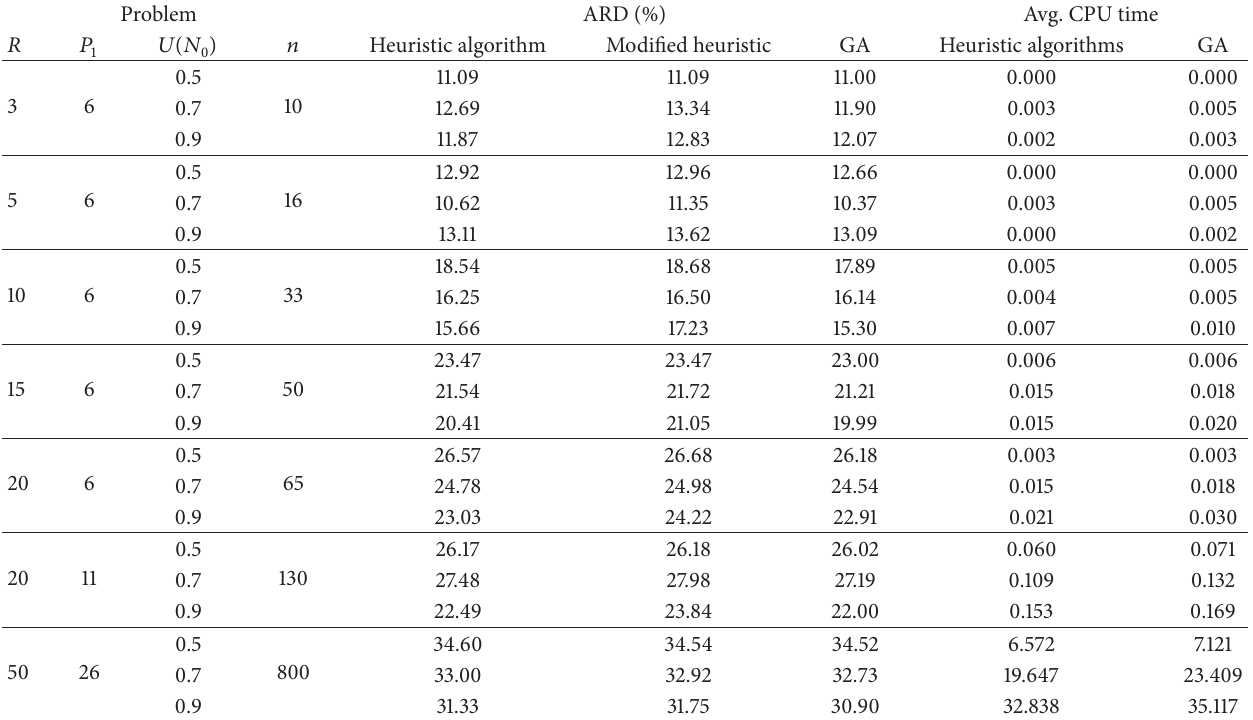
Table 3: Computing results of the heuristic algorithms for larger scale